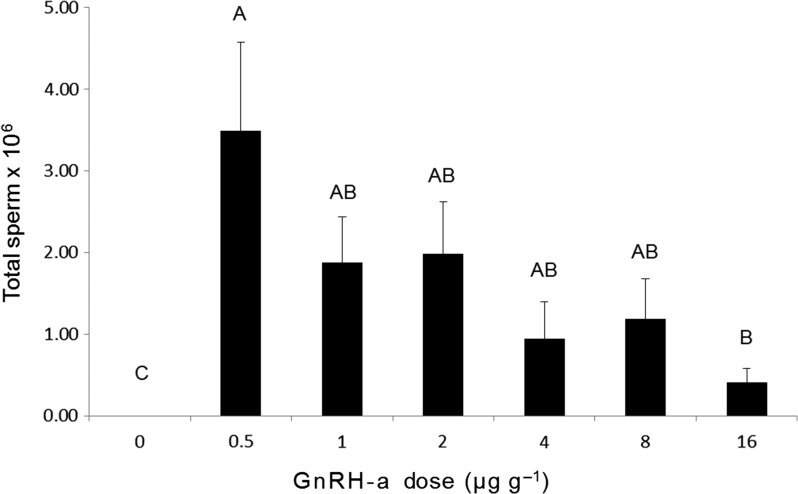
Effect of GnRH-a dose on the total number sperm released. Data are shown as the mean ± SEM (n = 8–12 per treatment). Letters displayed are the result of Wilcoxin post hoc tests. Treatments that share a letter are not significantly different (P > 0.05).